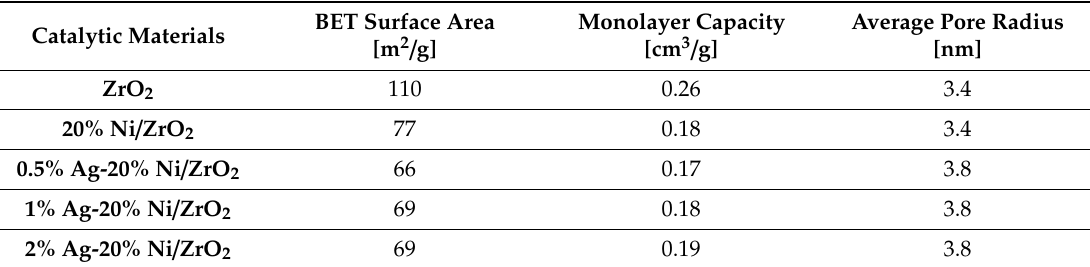
Table 4. Brunauer-Emmett-Teller (BET) surface area, monolayer capacity and average pore size for supports, mono- and bimetallic supported catalysts.